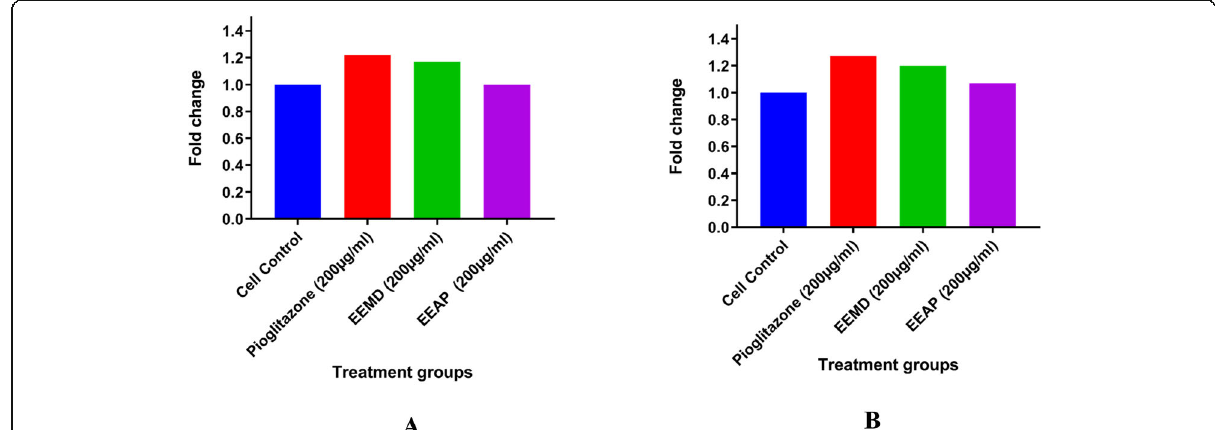
Fig. 6 Densitometric analysis of gene transcripts: a The relative level of GLUT-4 and b PPAR γ gene expression is normalized to GAPDH. Values shown depict arbitrary